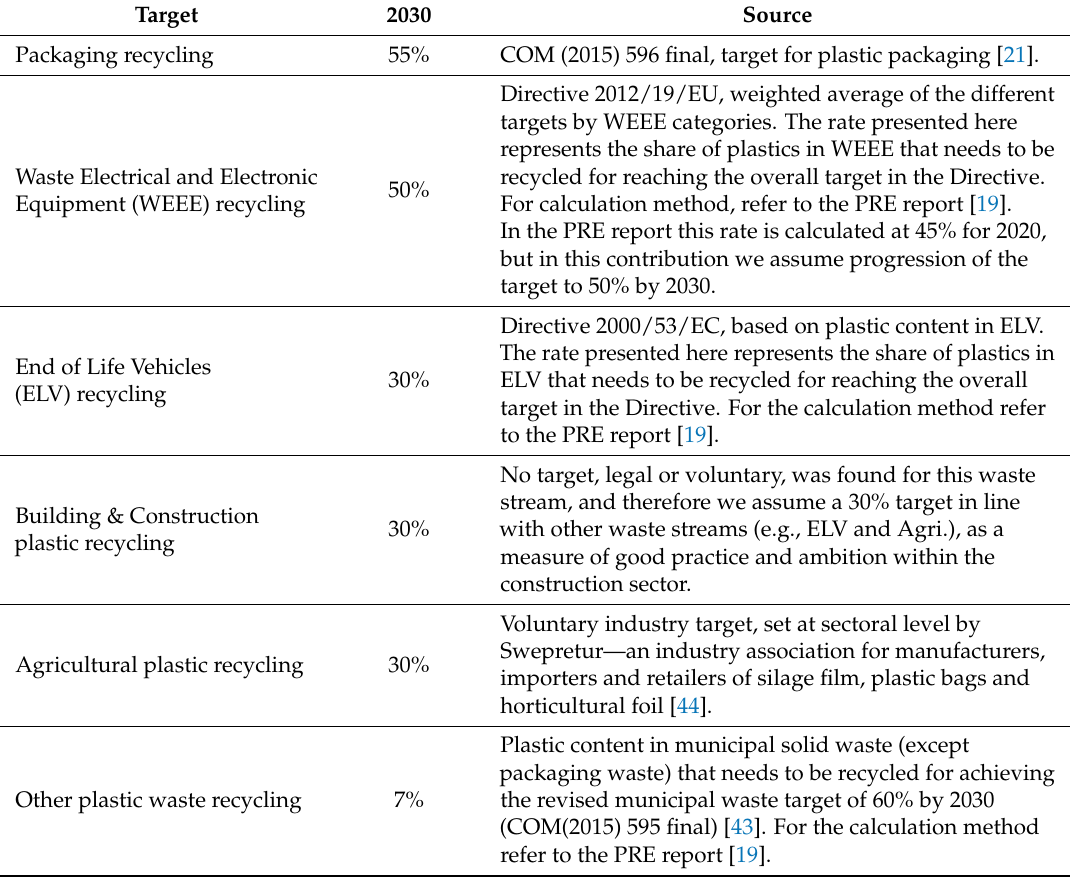
Table 1. Plastic recycling targets for 2030, by waste